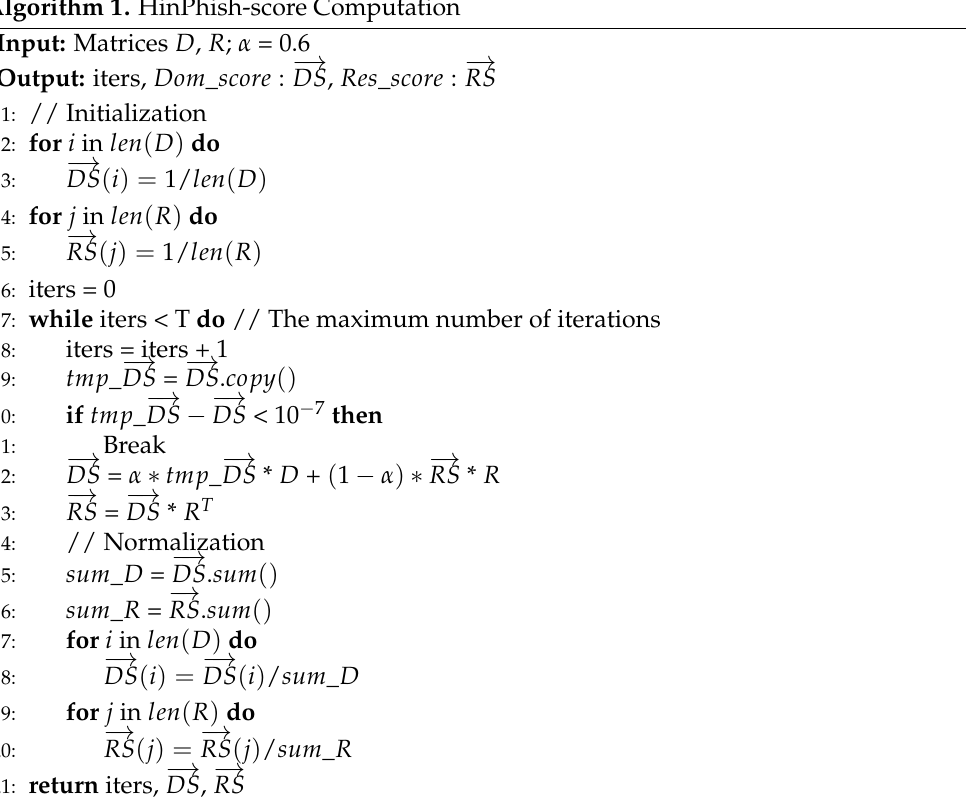
Algorithm 1. HinPhish-score